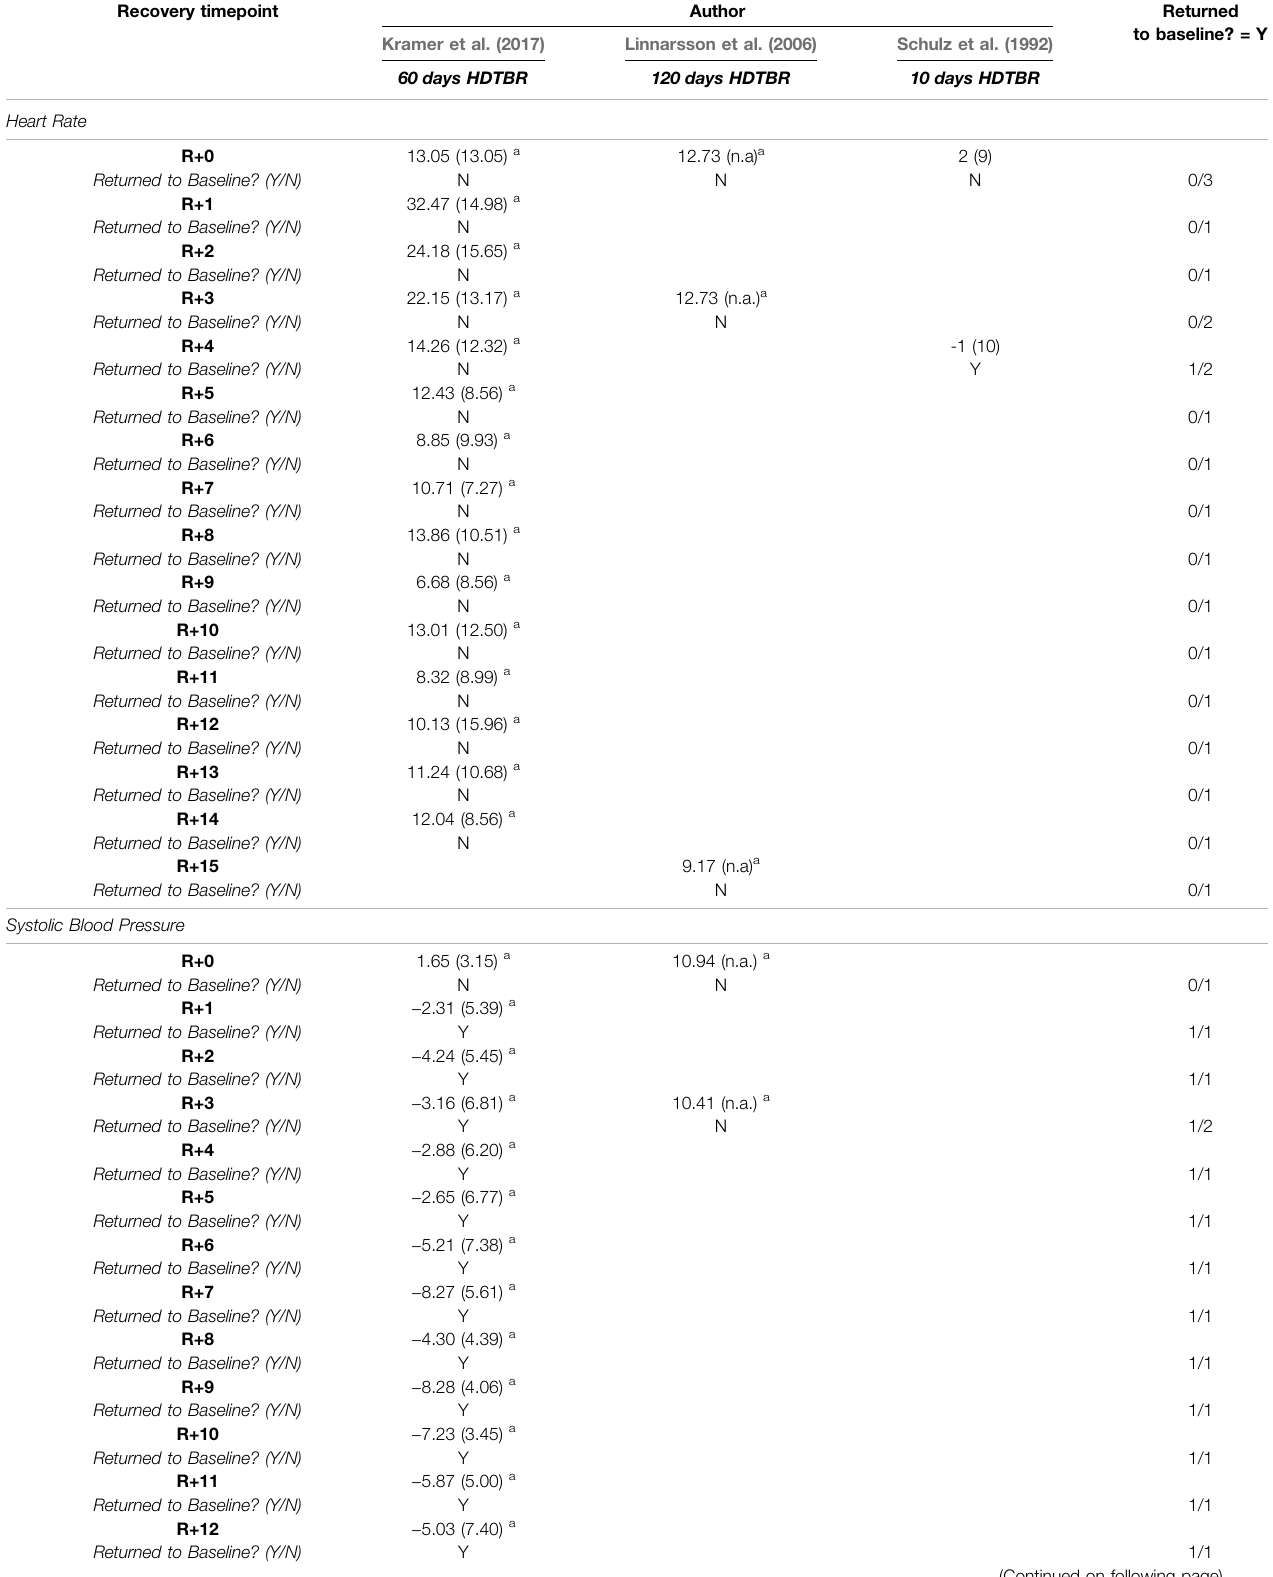
TABLE 6 | % Change with SD of outcome parameters related to the ‘ Cardiovascular System ’